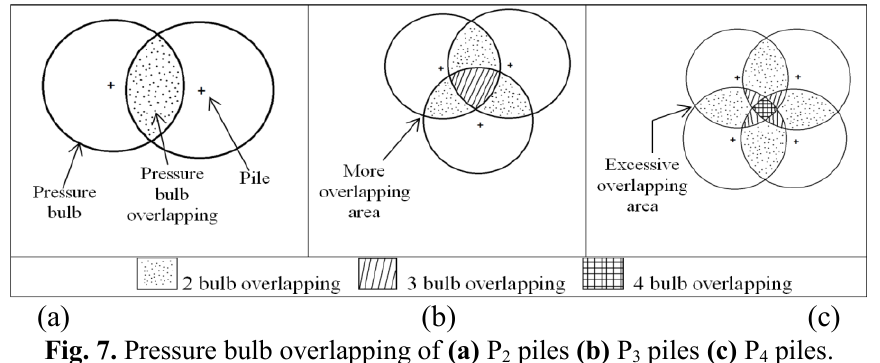
Fig. 7. Pressure bulb overlapping of (a) P